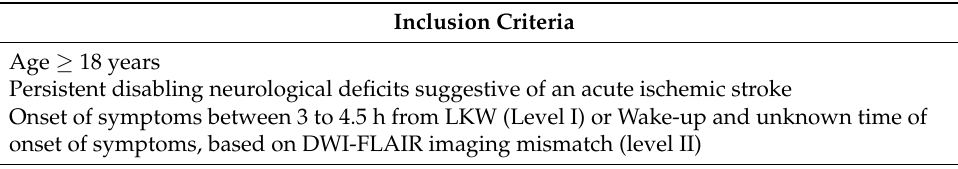
Table 1. Current Inclusion and Exclusion Criteria for IV alteplase based on AHA/ASA 2019 guide-